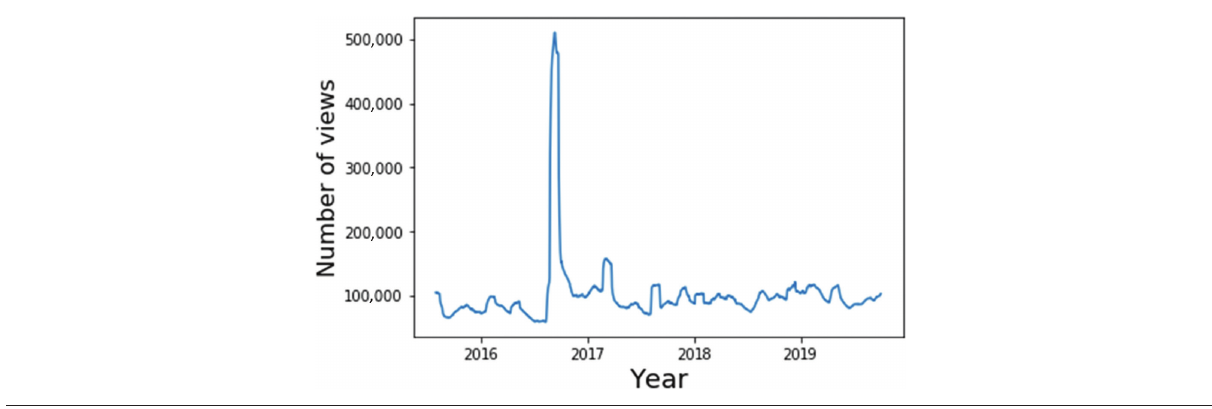
Figure 3. Daily viewing figures for Wikipedia articles about Proxima Centauri in 73 languages, where the curve has been smoothed with a 30-day rolling average (Source: